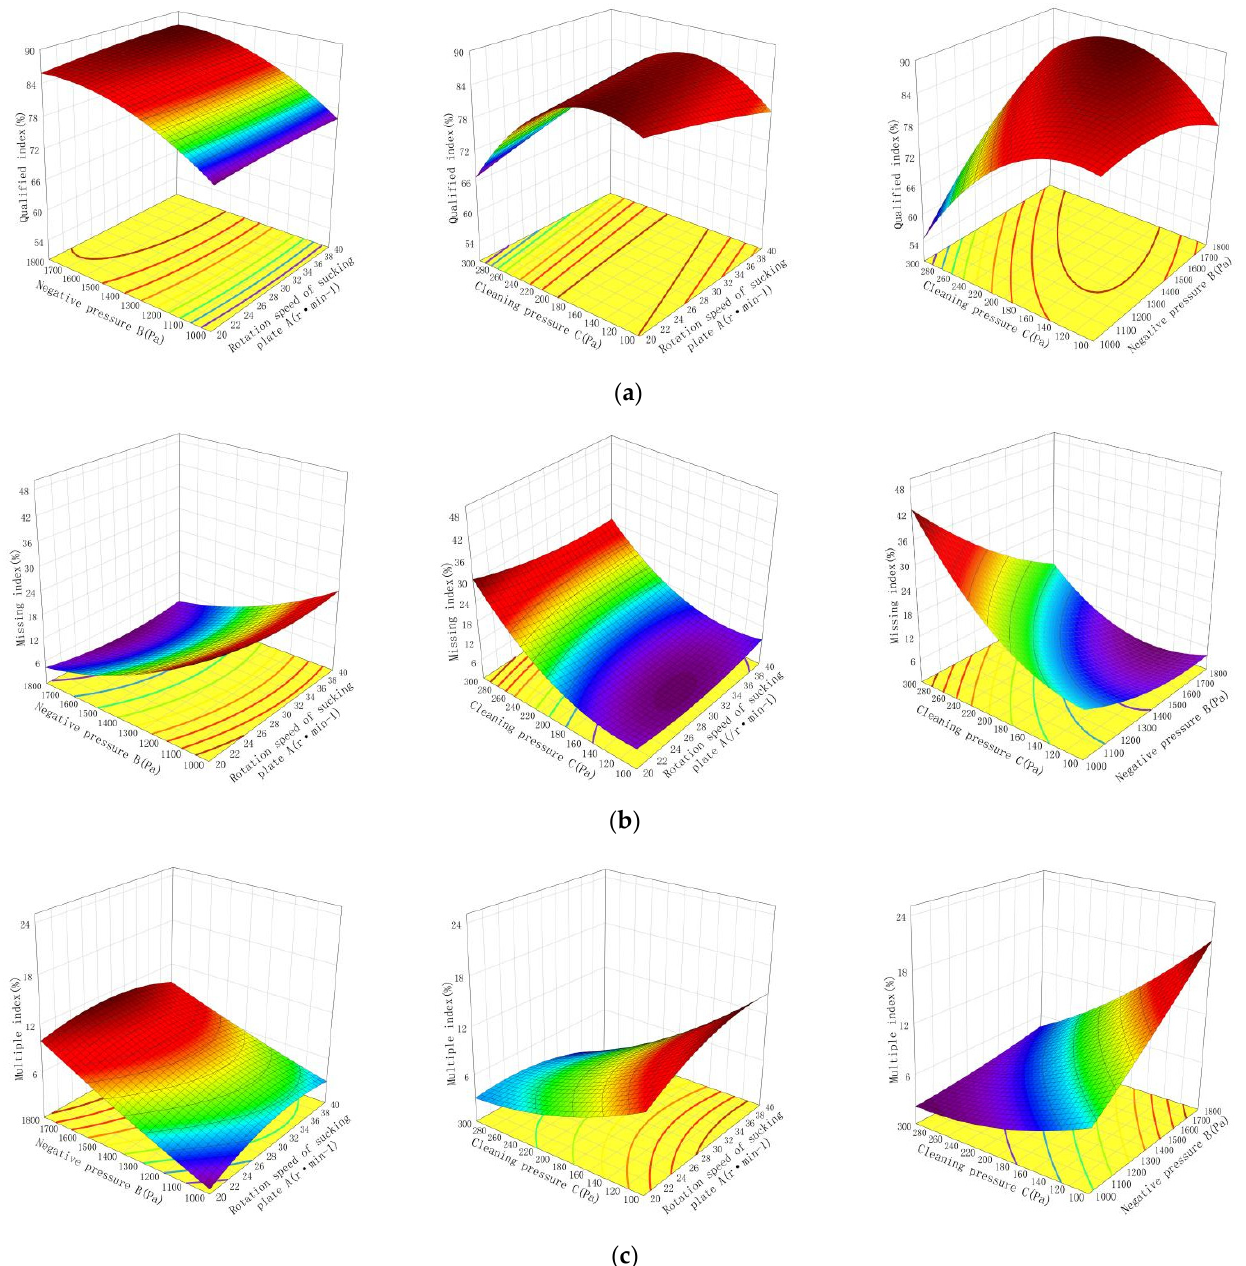
Figure 16. Response surface curve of interaction factors for test indexes: ( a ) the influence of interaction factors on qualified index; ( b ) the influence of interaction factors on missing index; ( c ) the influence of interaction factors on multiple index.